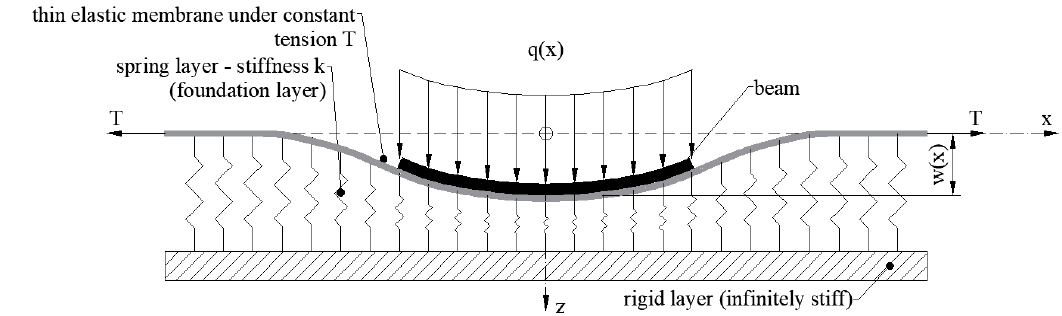
Figure 3. Beam on elastic foundation—Filonenko-Borodich model.